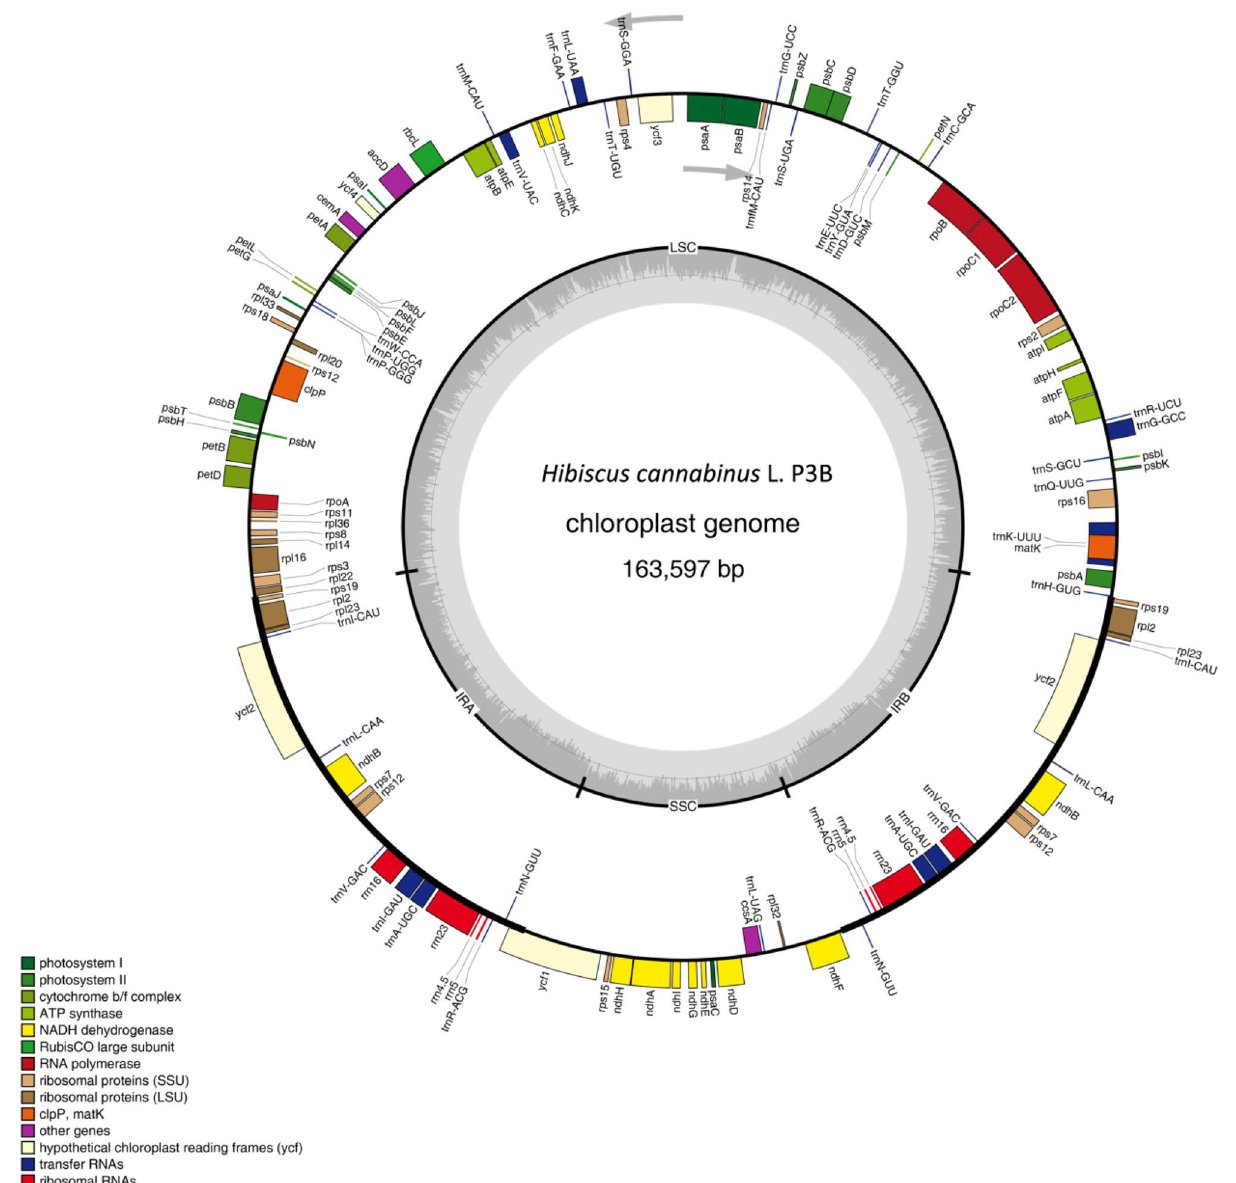
Figure 1. Circular gene map of Hibiscus cannabinus maintainer line (P3B). Genes drawn within the circle are transcribed clockwise, while those drawn outside are transcribed counter clockwise. Genes are colour-coded according to their functional